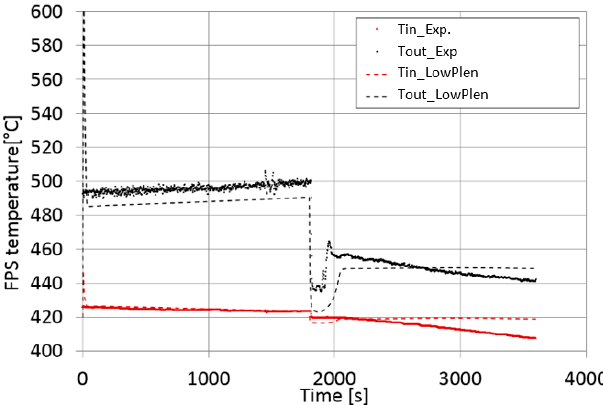
Figure 9. FPS inlet and outlet temperatures. Comparison between experimental and numerical results obtained by increasing the volume of the lower plenum.